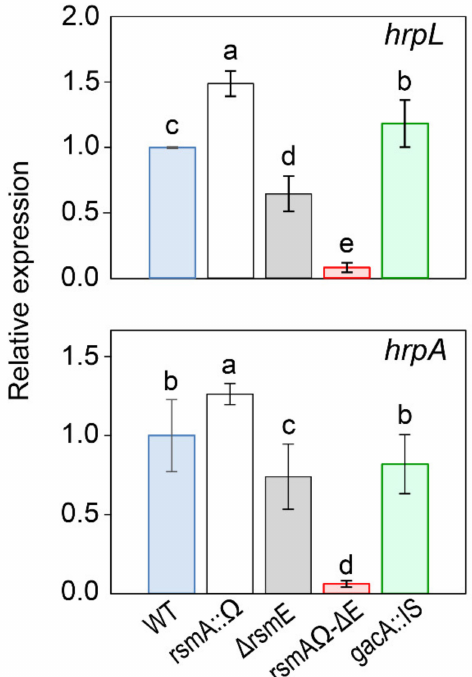
Figure 6. Expression analysis of type III secretion genes in P. amygdali pv. phaseolicola 1448A and derivative mutants. Bars indicate the expression of the indicated genes relative to strain 1448A (WT), after normalization with gene gyrA as an internal control, using quantitative real-time reverse transcription PCR (RT-qPCR). Letters above bars denote ANOVA categories with significant di ff erences ( p < 0.05). Error bars correspond to the standard deviation of three biological